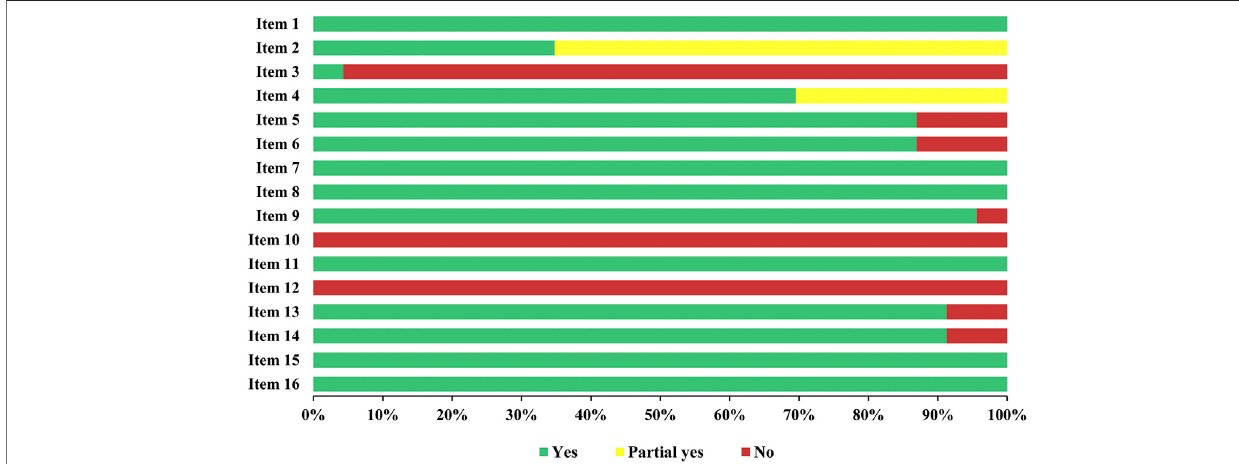
FIGURE 2 | Methodological quality of the included systematic reviews (SRs).